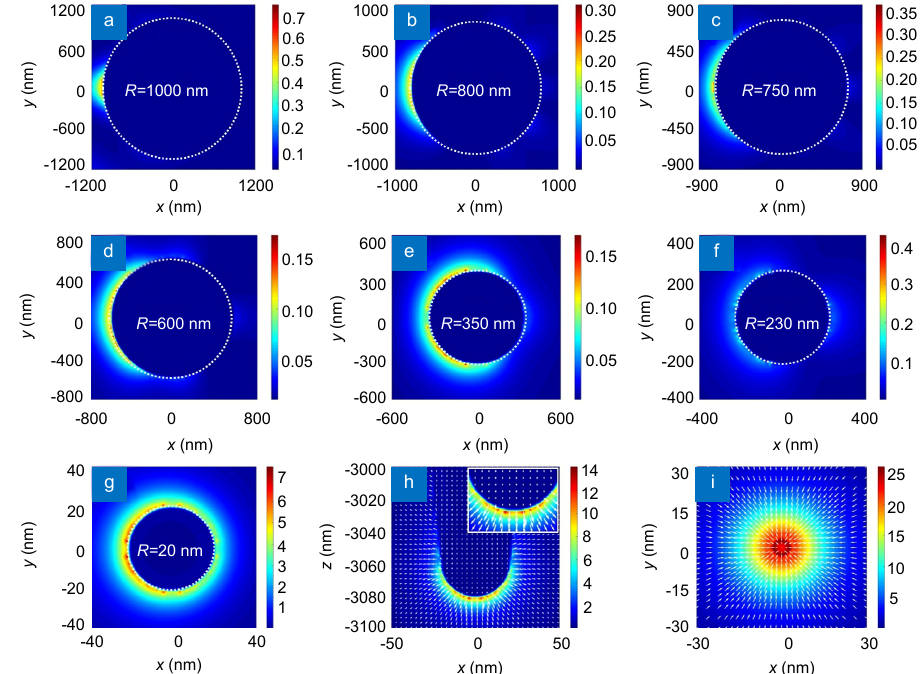
Fig. 4 | ( a ) Transverse mode intensity distributions of the grating-coupled SPPs at R =1 μ m; ( b – g ) Transverse mode intensity distributions of the hybrid mode at R =800, 750, 600, 350, 230, and 20 nm, respectively. ( h ) Electric field intensity distribution at the tip apex. ( i ) Transverse electric field intensity distribution at 1 nm below the tip